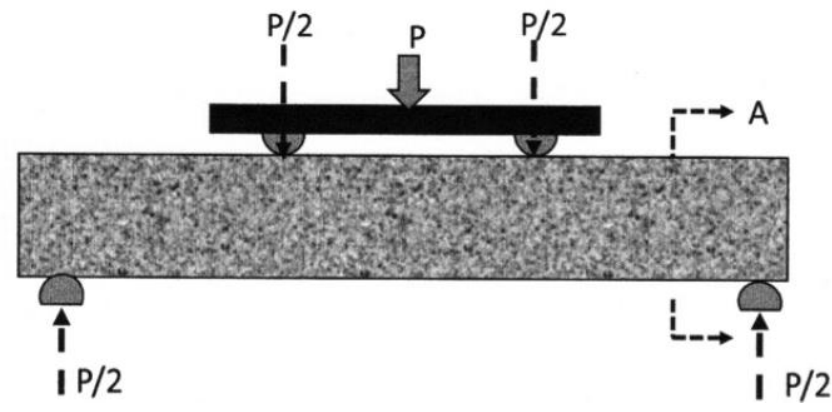
Figure 3. Experimental Setup for Flexural Strength [58].